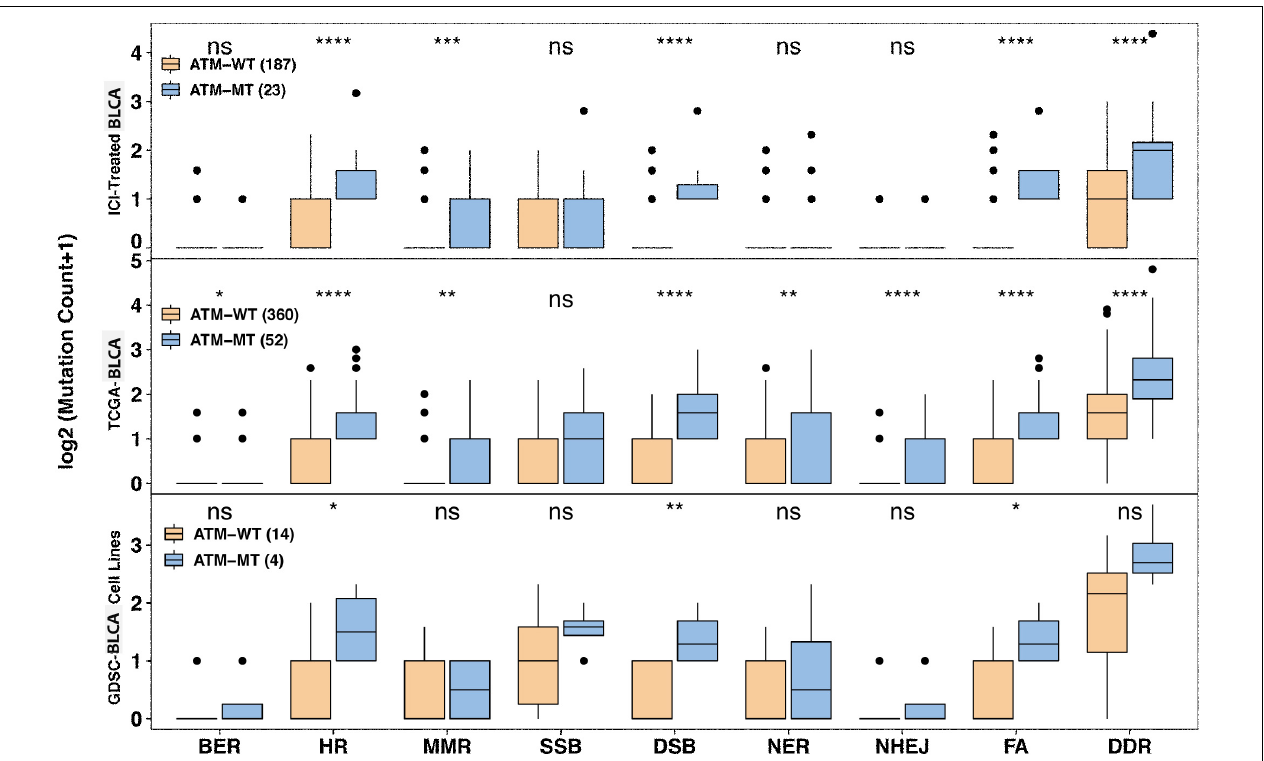
FIGURE 6 | Association between ATM mutation and mutated DNA damage repair pathway gene number variation. Mutated DNA damage repair pathway gene number variation increased in the ATM-MT group in the immunotherapy, TCGA-BLCA and GDSC-Bladder cancer cell line cohorts. The x axis indicates eight DDR-related pathways. BER, base excision repair; HR, homologous recombination; MMR, mismatch repair; SSB, single-stranded DNA binding; DSB, double-strand break repair; NER, nucleotide excision repair; NHEJ, non-homologous end-joining; FA, Fanconi anemia. * P < 0.05; ** P < 0.01; *** P < 0.001; **** P <